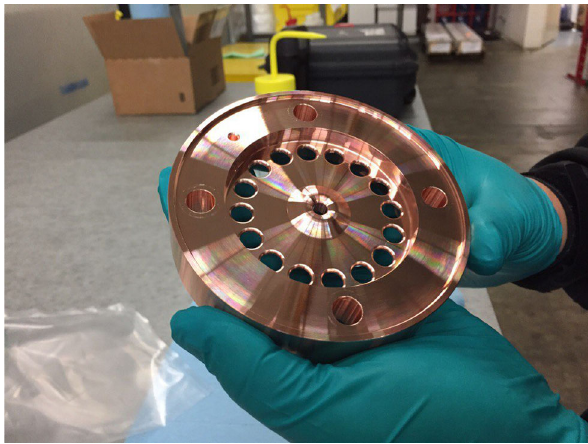
FIG. 22. Finished NHS test cell with all features included.